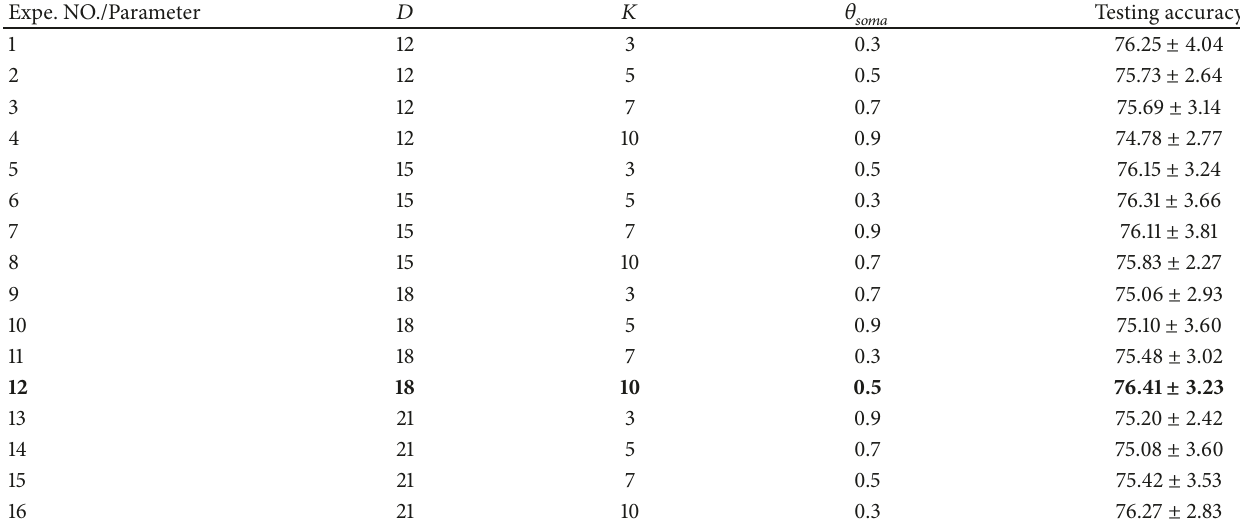
Table 4: 𝐿 16 (4 3 ) orthogonal array and factor assignment of the Distress data set.